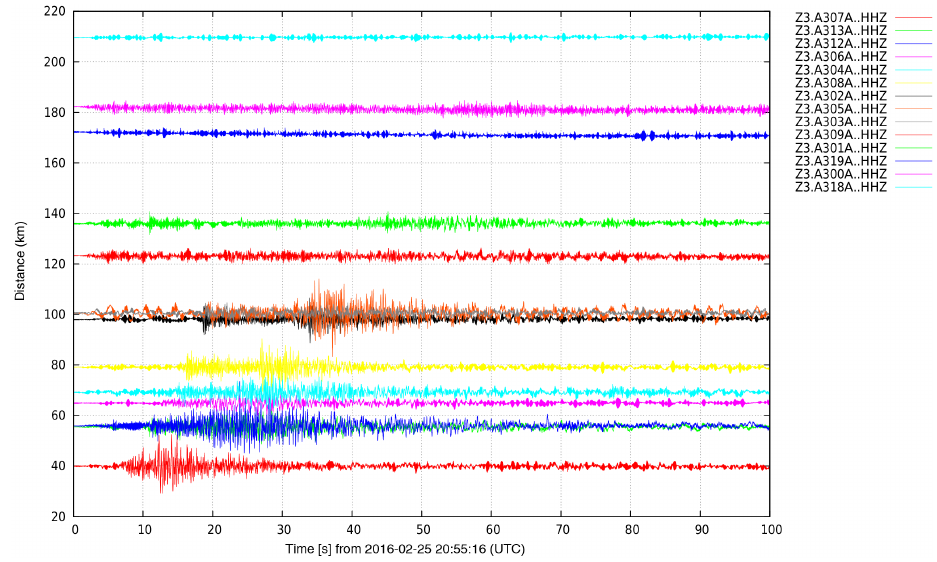
Figure 6. Example of waveforms recorded by the INGV AlpArray temporary stations for the M3.0 local earthquake occurred close to Poggio Rusco (Mantova, Italy) on 25 February 2016, 20:55:16 (UTC), 10km focal depth. Waveforms are corrected for instrument response.